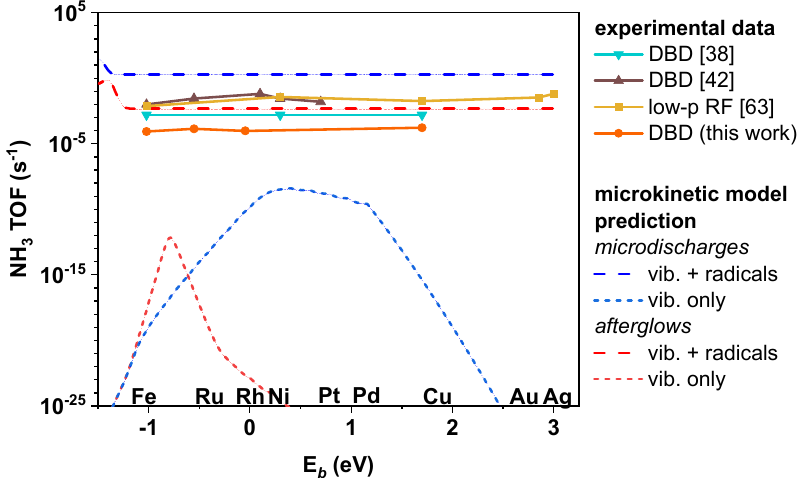
Figure 8. Comparison between the NH 3 TOF values obtained in our experiments, as well as in literature, and predicted by the microkinetic computational model (described in detail elsewhere [43]). TOFs are showcased as a function of the N* binding energy on the metal terrace sites.